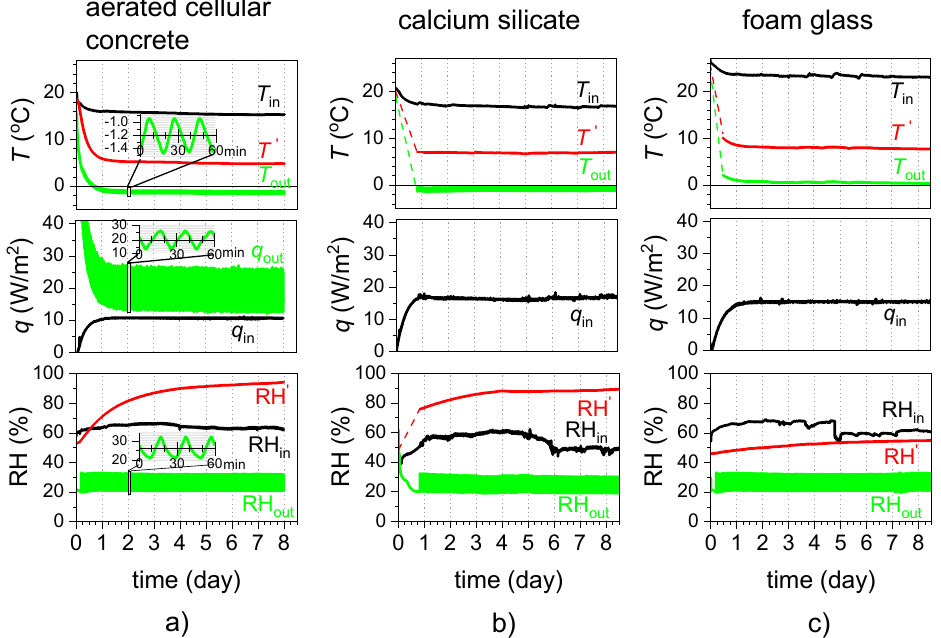
Figure 4. Time dependences of temperature, heat flux, and RH for three wall specimens with different interior insulations and the very same brick wall. Due to the unknown technical problem, the sensors for T ′ , T out , and RH ′ in panels ( b , c ) did not record the data for the first 20 h and 12 h, respectively.